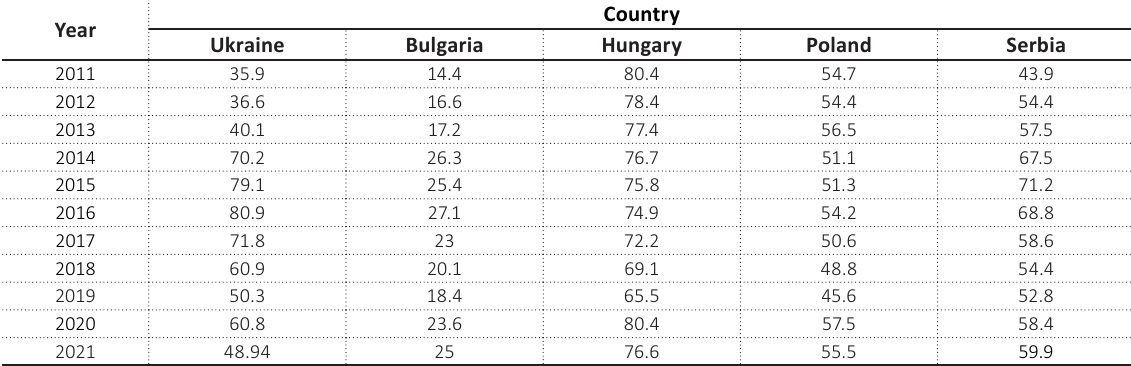
Table A3 (cont.). General government gross debt, Ukraine, Bulgaria, Hungary, Poland, and Serbia, 2006–2021, in % of